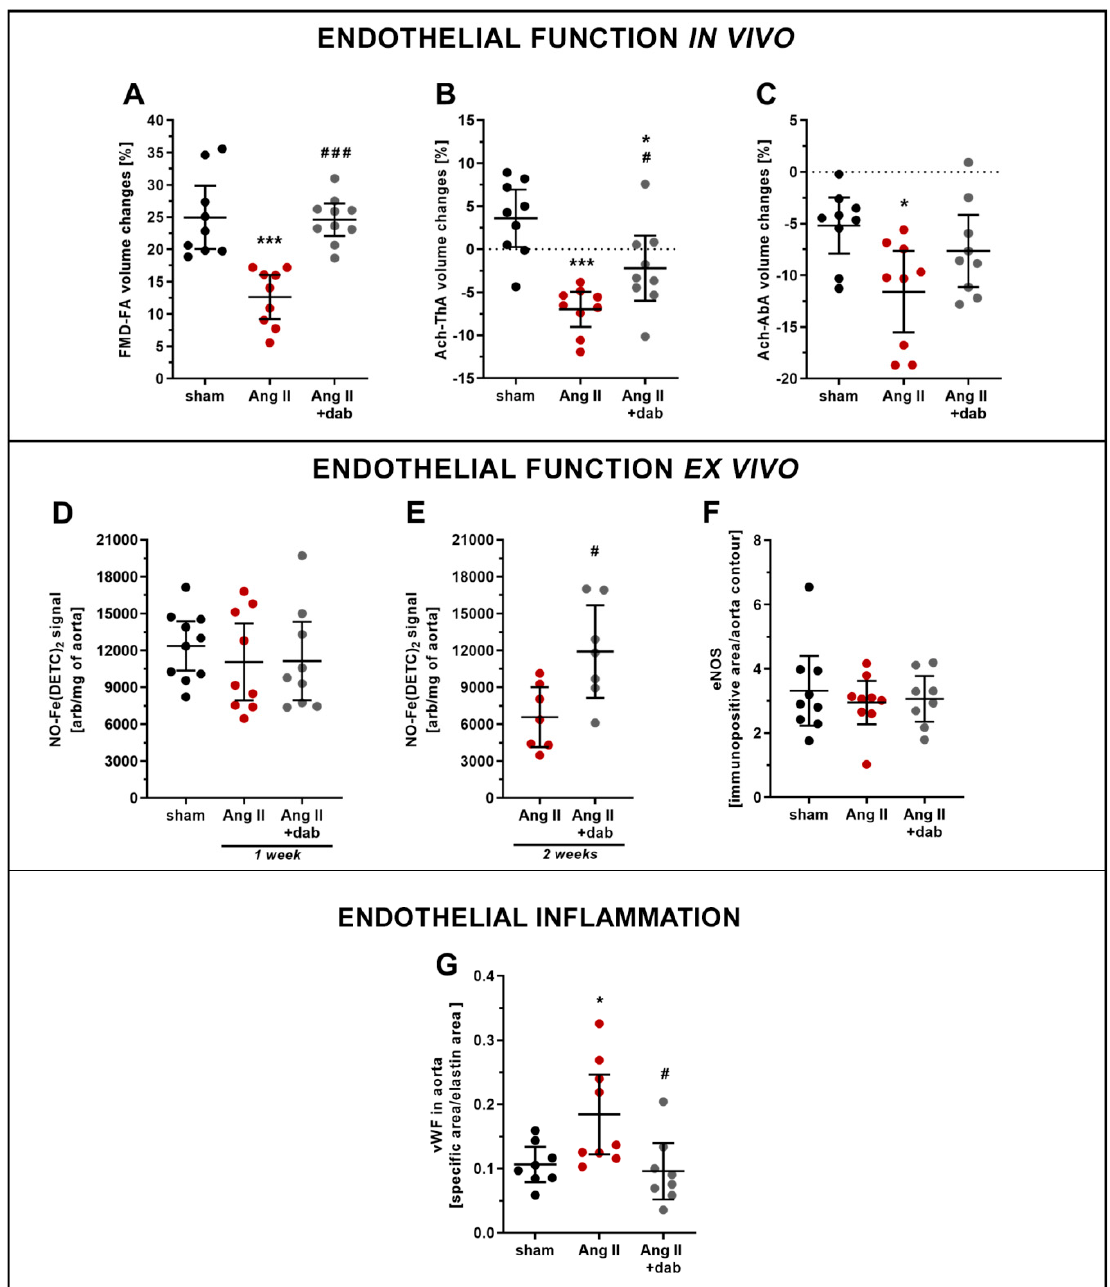
Figure 3. Effect of dabigatran on endothelial function and inflammation in Ang II hypertensive mice. Endothelial function assessed by MRI technique in vivo as changes in flow-mediated vasodilation response in the femoral artery FMD-FA ( A ; n = 9), Ach-induced vasodilation in thoracic aorta Ach-ThA ( B ; n = 9), and abdominal aorta Ach-AbA ( C ; n = 9) were evaluated in mice subjected to s.c. administration of Ang II (1 mg/kg b.w. per day; 1 week) via micro-osmotic pumps. Endothelial function assessed ex vivo based on the NO-Fe(DETC) 2 signal measured by EPR as well as eNOS expression in aorta (IHC analysis) were evaluated in mice subjected to s.c. administration of Ang II (1 mg/kg b.w. per day; 1 week) via micro-osmotic pumps ( D , F ; n = 8–10) and i.v. continuous infusion of Ang II (144 µg/kg b.w. per day; 2 weeks) via catheters ( E ; n = 7). The aorta area positively stained for pro-inflammatory marker such as vWF ( G ; n = 7–9) was evaluated in mice subjected to s.c. administration of Ang II (1 mg/kg b.w. per day; 1 week) via micro-osmotic pumps. Data are shown as means (–) ± 95% CI (I) and considered statistically significant at * p ≤ 0.05, *** p ≤ 0.001, # p ≤ 0.05 and ### p ≤ 0.001 using Tukey’s post hoc ( A – D , F , G ) and t-test ( E ) statistical tests. * indicates statistical difference between sham mice and Ang II- or Ang II+ dab-treated animals, # indicates statistical difference between Ang II- and Ang II+ dab-treated mice.